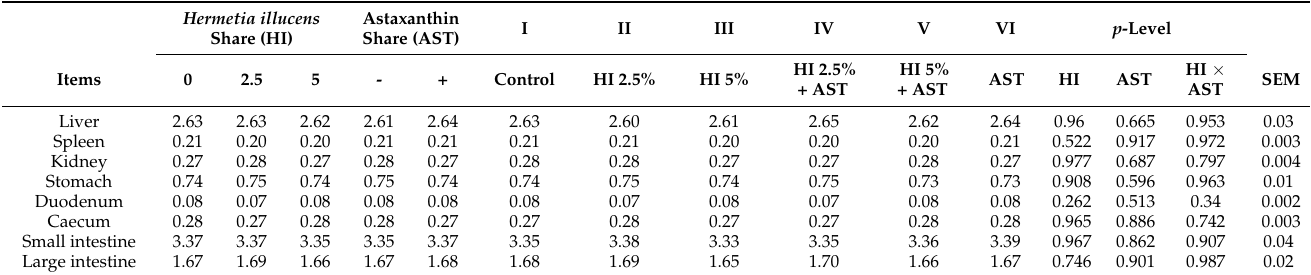
Table 3. Effect of Hermetia illucens meal share and astaxanthin presence in feed on the weight of organs and digestive tract sections of